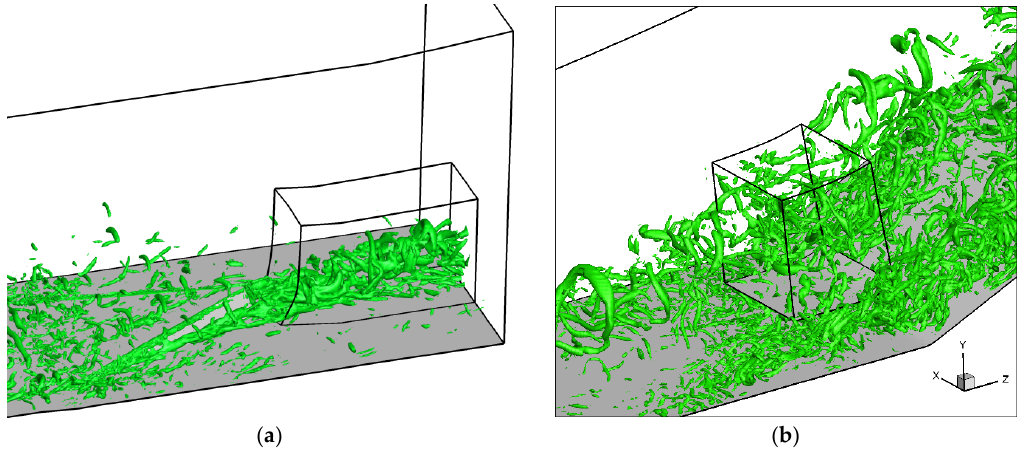
Figure 5. Vortical structures and the position of subzones: ( a ) behind the MVG, ( b ) in SWBLI region.